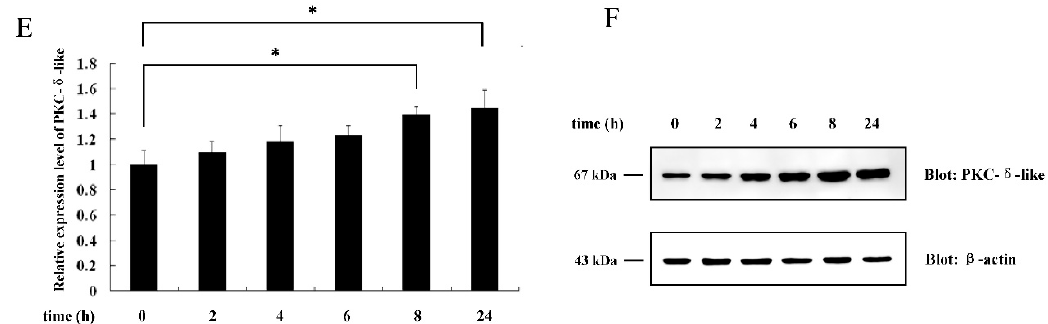
Figure 1. The e ff ect of di ff erent immunogens on the expression of protein kinase C- δ -like (PKC- δ -like) in the leukocytes of L. japonica . ( A ) The lampreys were immunized withlipopolysaccharide(LPS), teichoic acid, Poly (I:C), and control. The mRNA levels of PKC- δ -like in the leukocytes of L. japonica were detected. ( B ) The lampreys were immunized with LPS, teichoic acid, Poly (I:C), and control. The protein levels of PKC- δ -like, together with the phosphorylation level of ERK1 / 2, in the leukocytes of L. japonica were detected. ( C ) The leukocytes of L. japonica were incubated with LPS at di ff erent concentrations (0, 0.1, 1, 10, 100 µ g / mL). The mRNA levels of PKC- δ -like were detected. ( D ) The leukocytes of L. japonica were incubated with LPS at di ff erent concentrations (0, 0.1, 1, 10, 100 µ g / mL). The protein levels of PKC- δ -like were detected. ( E ) The leukocytes of L. japonica were incubated with LPS for di ff erent hours (0, 2, 4, 6, 8, and 24 h). The mRNA levels of PKC- δ -like were detected. ( F ) The leukocytes of L. japonica were incubated with LPS for di ff erent hours (0, 2, 4, 6, 8, and 24 h). The protein levels of PKC- δ -like were detected. The asterisk indicates p < 0.05.